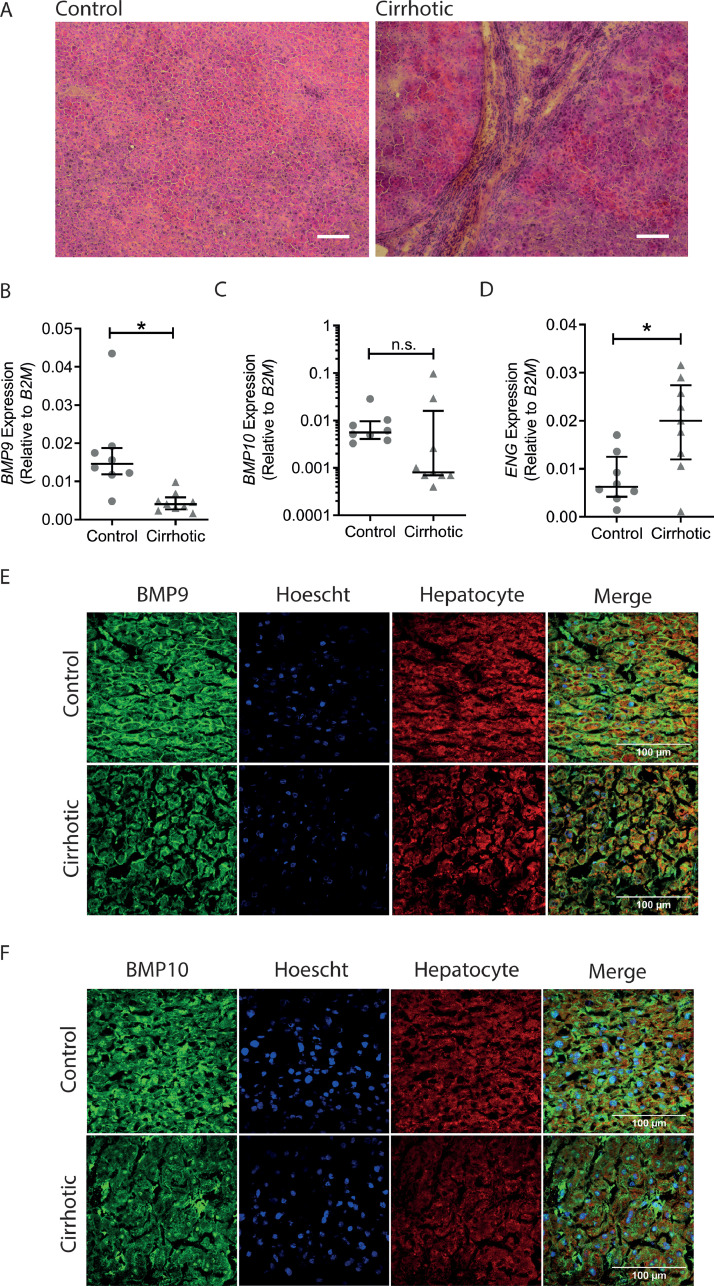
Liver BMP9 and BMP10 are present in hepatocytes and their expression levels are reduced in cirrhosis, whereas endoglin expression is increased. (A) Low power image (10X) of control and cirrhotic liver sections stained with haematoxylin and eosin (White scale bar length = 30 µm). (B–D) Total RNA was extracted from control (n = 8) and cirrhotic (n = 9) liver samples and analysed by qPCR for (B) BMP9, (C) BMP10 and (D) ENG expression. Mann Whitney Test *P<0.05. (E,F) 8 healthy human liver samples and 9 samples from patients with cirrhosis were stained with Hoescht nuclear stain (blue) and a hepatocyte-specific antibody (red) in addition to antibodies (green) for (E) BMP9 or (F) BMP10. Images were captured using confocal microscopy and 100 µm scale bars are shown.(For interpretation of the references to color in this figure legend, the reader is referred to the web version of this article.)